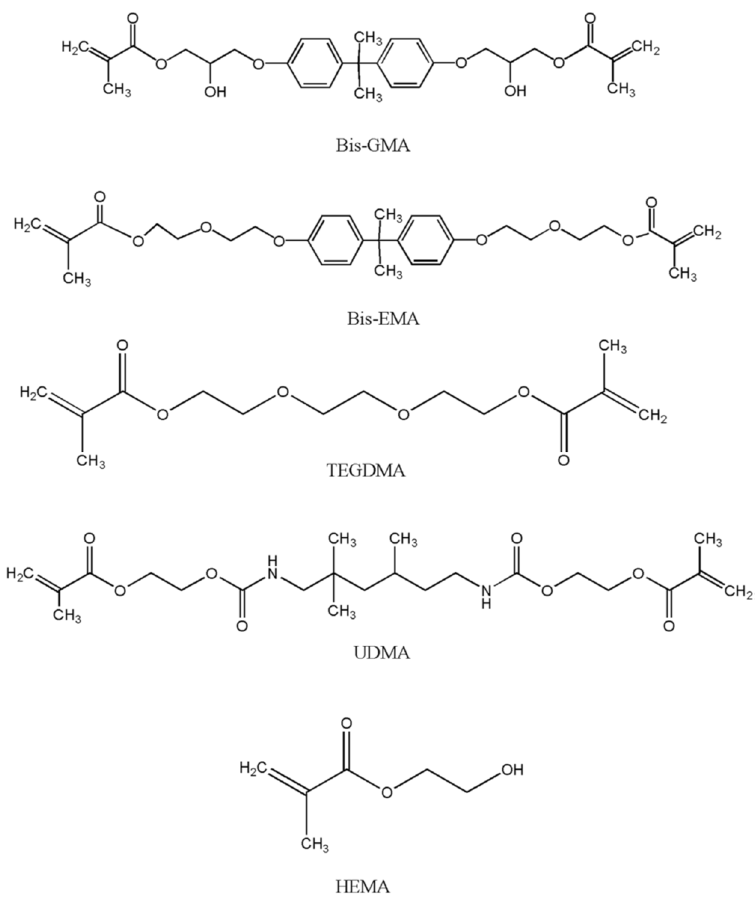
Figure 1. Dimethacrylate monomers.